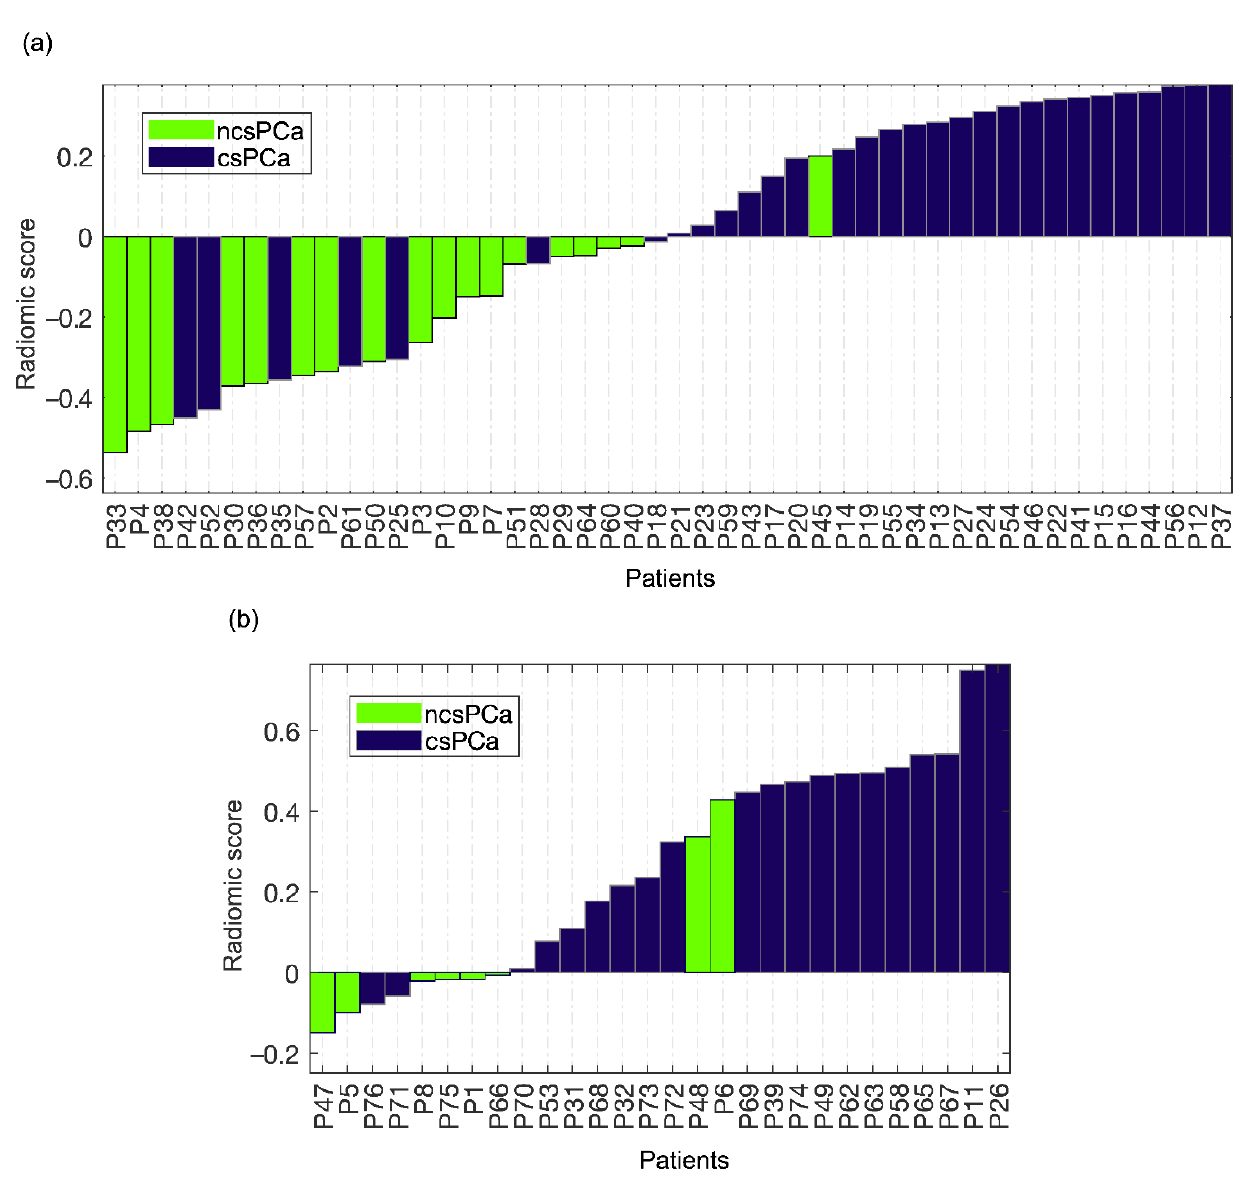
Figure 5. ( a ) Waterfall plot achieved for the predictive model based on DWI b2000 on the training set. ( b ) Waterfall plot achieved for the predictive model based on DWI b2000 on the holdout test set.